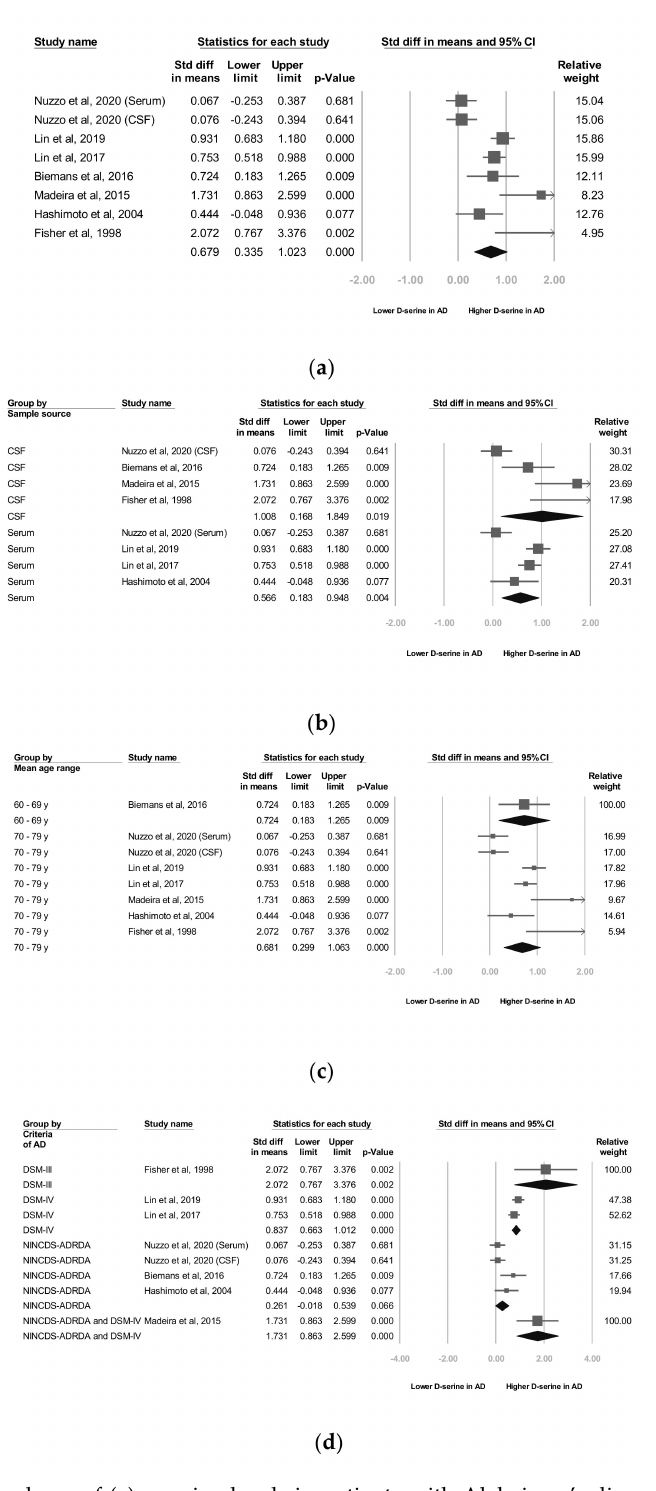
Figure 2. Meta-analyses of ( a ) d -serine levels in patients with Alzheimer’s disease and in controls, ( b ) subgroups segmented by d -serine source, ( c ) subgroups segmented by mean age range, and ( d ) subgroups segmented by Alzheimer’s disease criteria. (Note: in the graph, the square represents the e ff ect size of each study. The bigger the square, the more participants in the study. A horizontal line represents the 95% confidence intervals of the study result, with each end of the line representing the boundaries of the confidence interval. The diamond represents the combined e ff